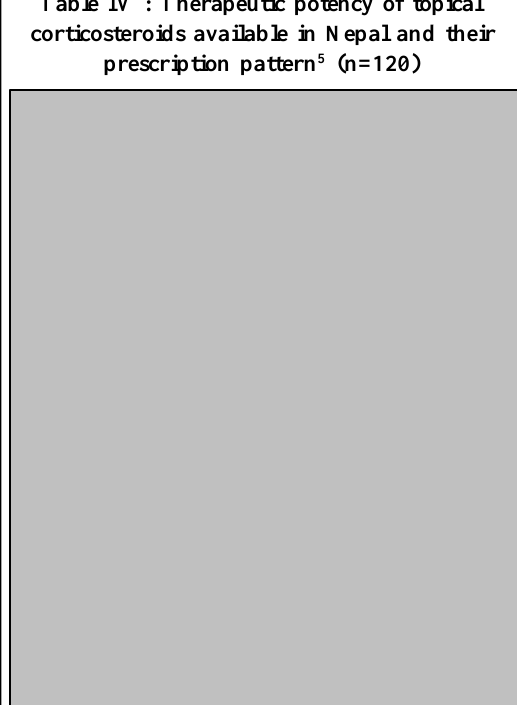
Table IV : Therapeutic potency of topical corticosteroids available in Nepal and their prescription pattern 5